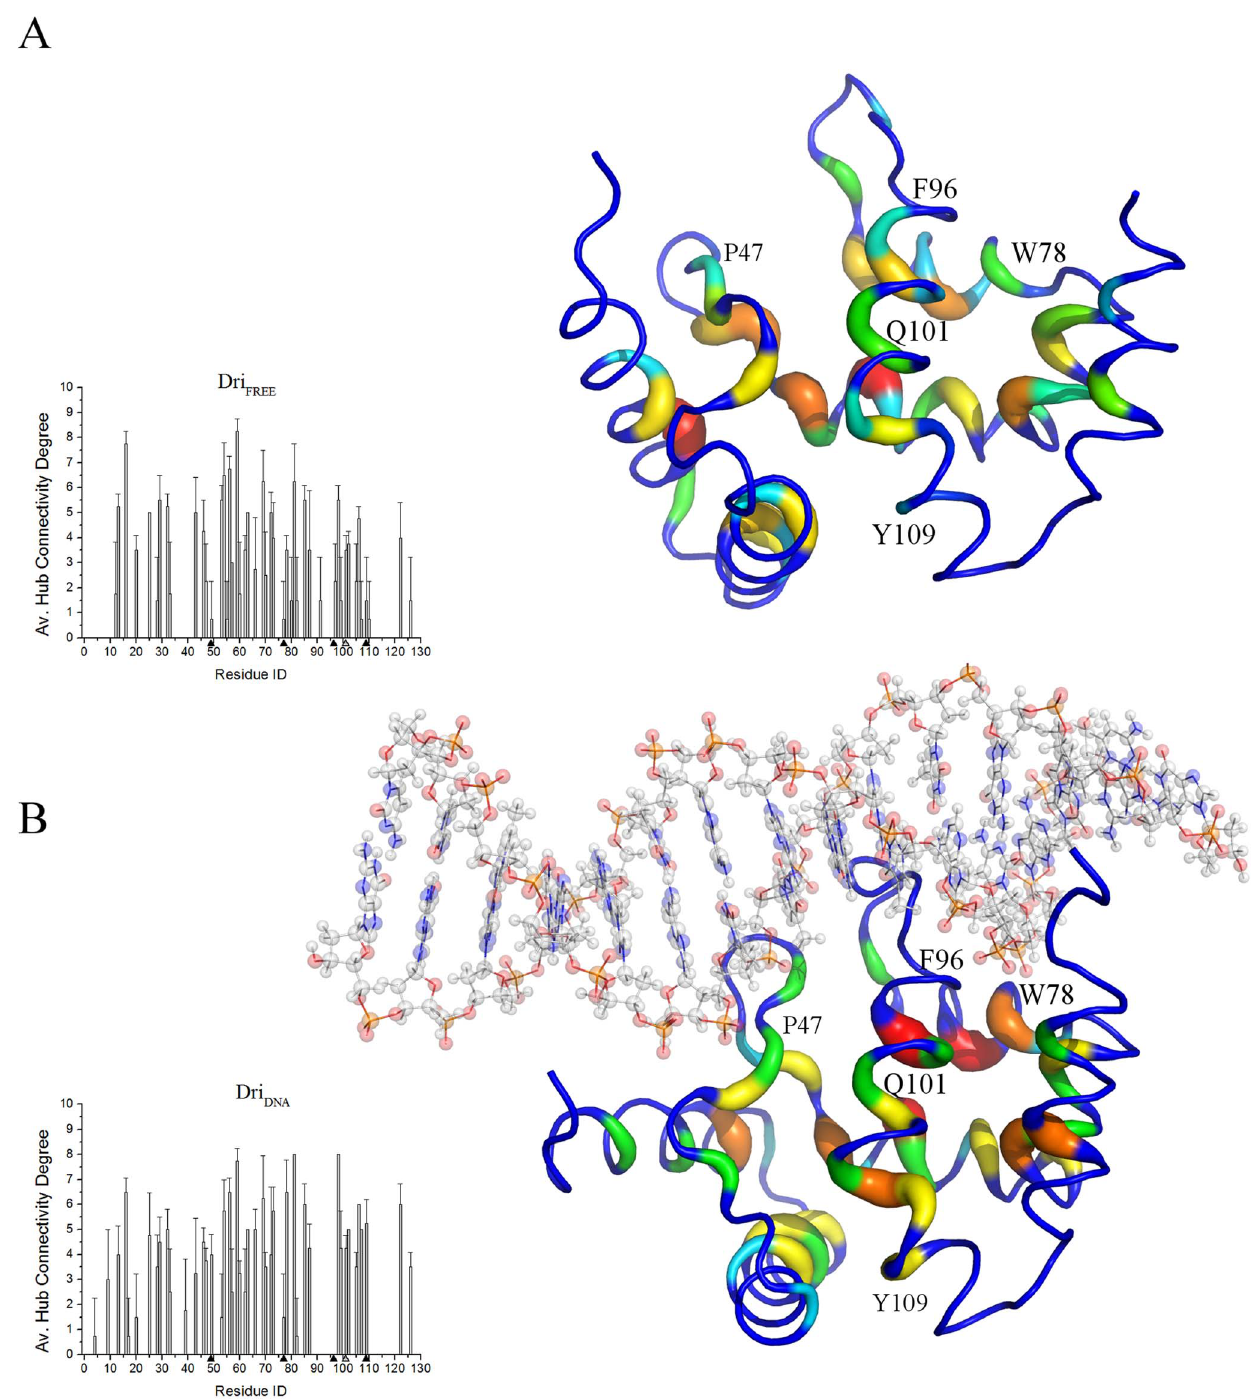
Figure 4. Hub residues and their location on the 3D structure of ARID domains. The connectivity degree for each PSN hub of Dri FREE (A) and Dri DNA (B) simulations are shown as a function of the protein residue in the left panels. Since in a PSN a hub is defined as a residue connected by at least three edges, all the residues with node degree lower than three are set at zero. Black triangles indicate the position of the residues experimentally known to impair DNA-binding [9], whereas a gray triangle indicates Q101/Q111 position. The right panels show the location of these hubs on a reference 3D structure of the corresponding target protein. The structure is depicted as ribbon with rainbow shade of colors according to the node degree. The corresponding figures for ARID3A FREE and 1 m s Dri FREE simulations are shown in Figure S4. The residue numbering is referred to Dri in the figure where P47, W78, F96, Q101 and Y109 correspond to P57, W88, F106, Q111 and Y119 in ARID3A.